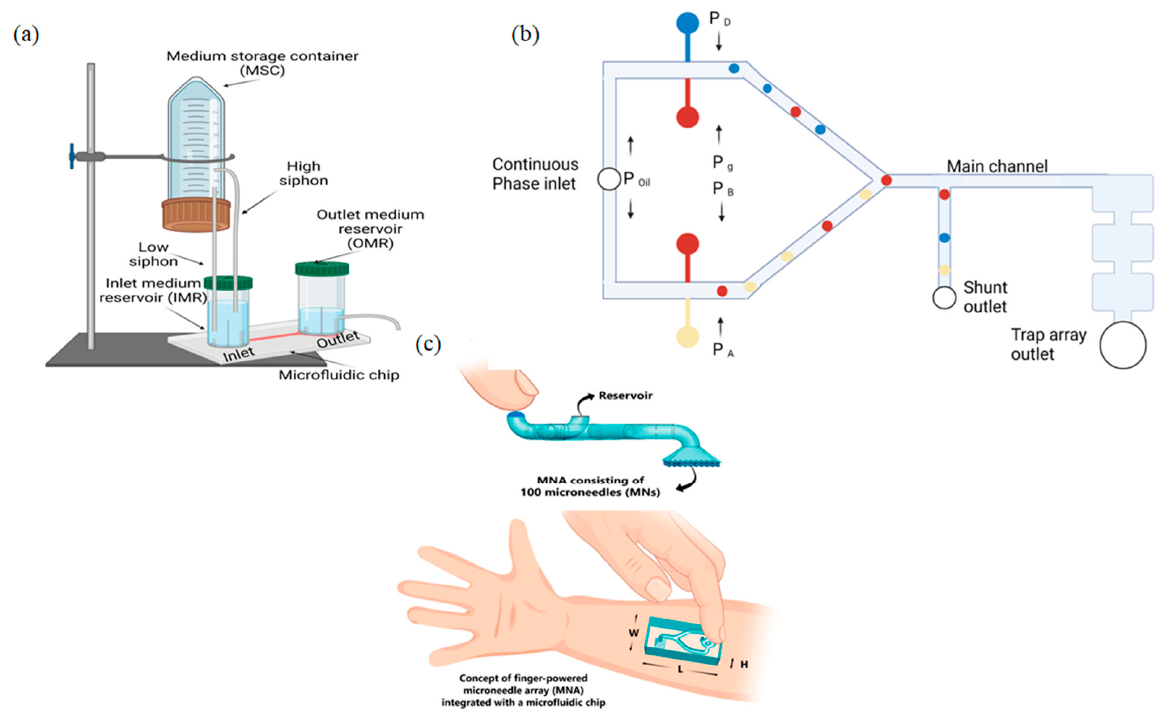
Figure 3. Examples of pressure-driven systems: ( a ) pump with siphon-based autofill function; ( b ) pressure-driven droplet generating system; ( c ) finger-powered microneedle array combined with microfluidic chip (from M. R. Sarabi et al. [99]).